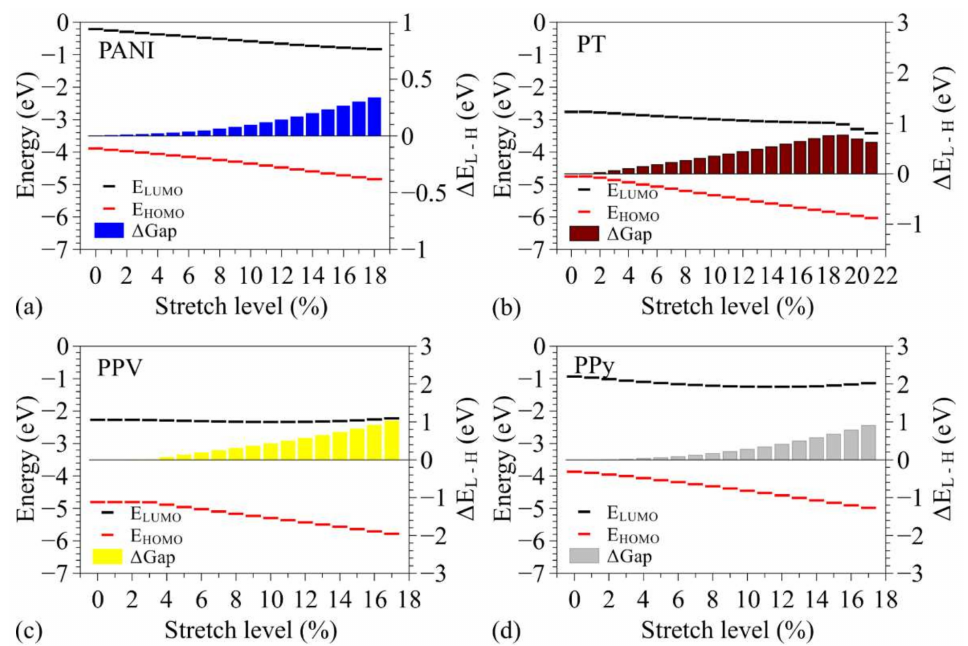
Figure 5. Evolution of the FMO energy levels with stretching of the oligomers: ( a ) PANI, ( b ) PT, ( c ) PPV, and ( d )